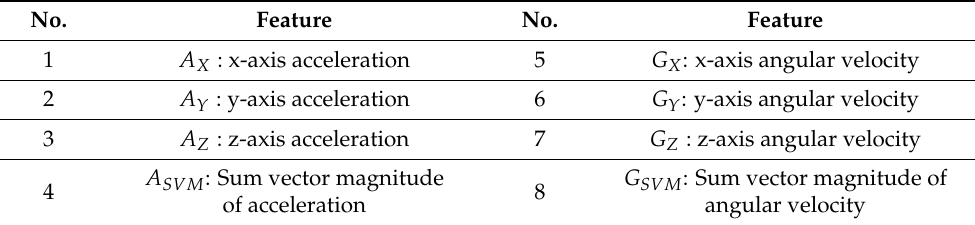
Table 2. Eight features used in this